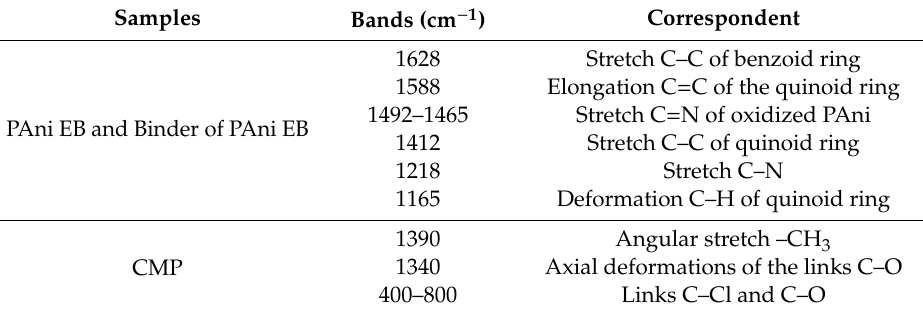
Figure 2. Raman spectrum of PAni EB, PAni EB binder, and CMP. Table 1. Raman spectroscopy for PAni EB, PAni Binder, and CMF samples.